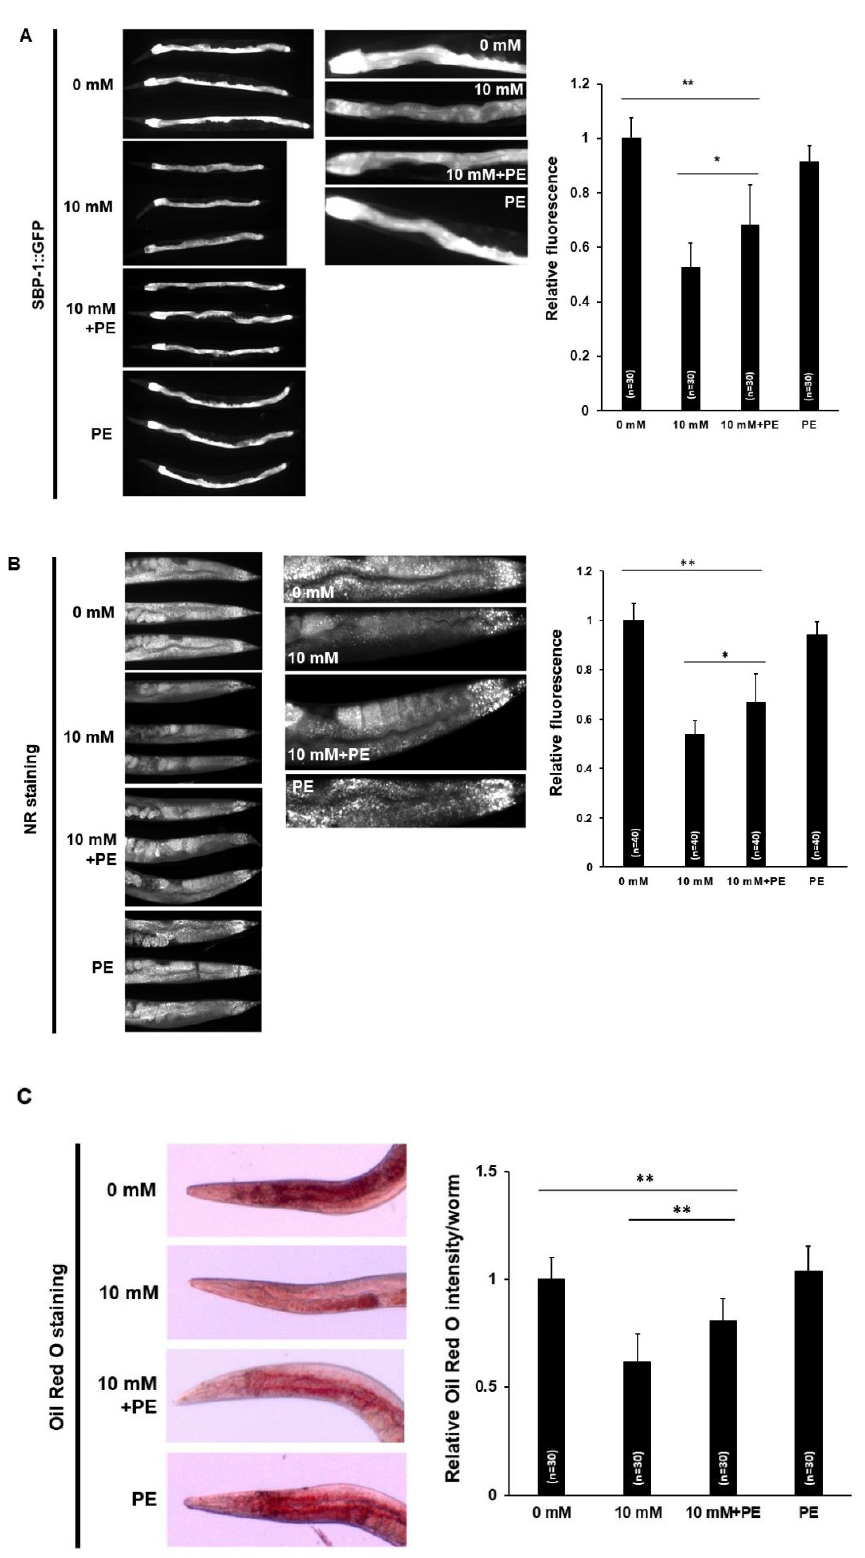
Figure 7. Phosphoethanolamine (PE) supplementation improves lipogenesis and fat storage affected by caffeine intake in Caenorhabditis elegans . ( A ) SBP-1::GFP transgenic animals synchronized at the L4-stage were exposed to caffeine with PE supplementation for 24 h at 20 °C. An increased level of SBP-1::GFP in the intestine was observed in animals fed caffeine with PE supplementation. Statistical significance was calculated using one-way ANOVA. *, p < 0.05. **, p < 0.01. Error bars represent